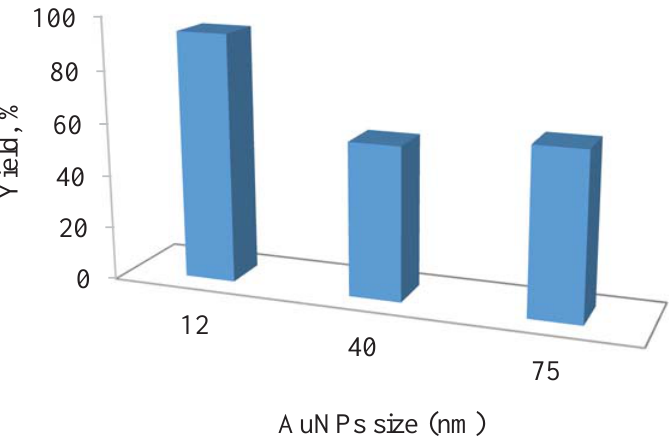
Figure 7. Conversion of 4-nitrophenol (4-NP) to 4-aminophenol (4-AP) as a function of the size of the AuNPs, in the first 6 min of reaction. [AuNPs] = 3.2 × 10 − 5 M; [4-NP] = 3.8 × 10 − 5 M; [NaBH 4 ] = 1.6 × 10 − 3 M.